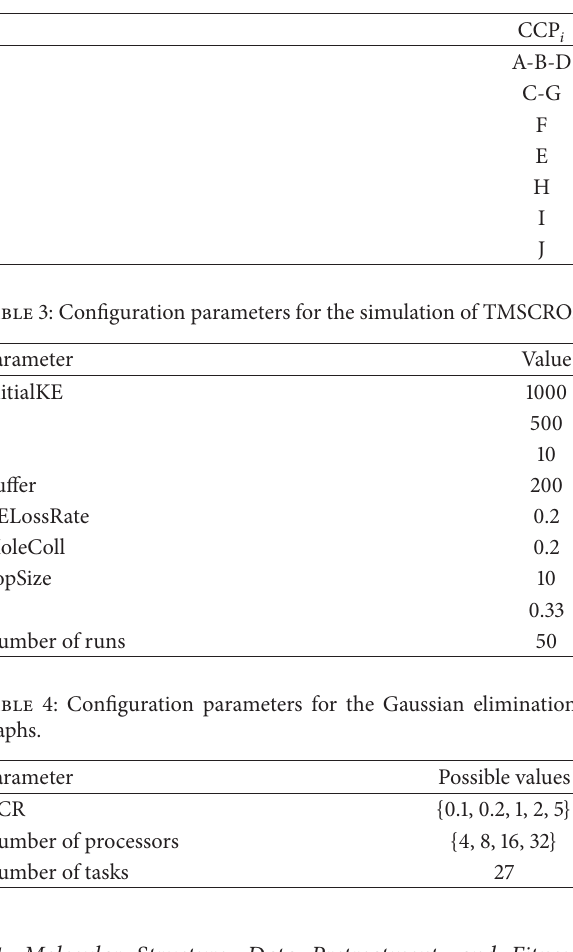
Table 2: CCP corresponding to the DAG as shown in Figure 1(1).